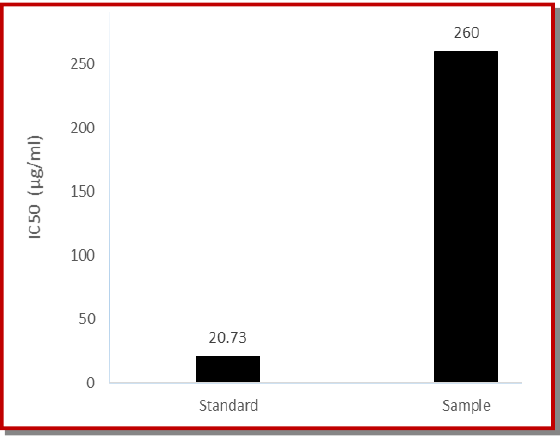
Figure 2: IC 50 values of the standard BHT and sample meth- anolic extract of X. indicum